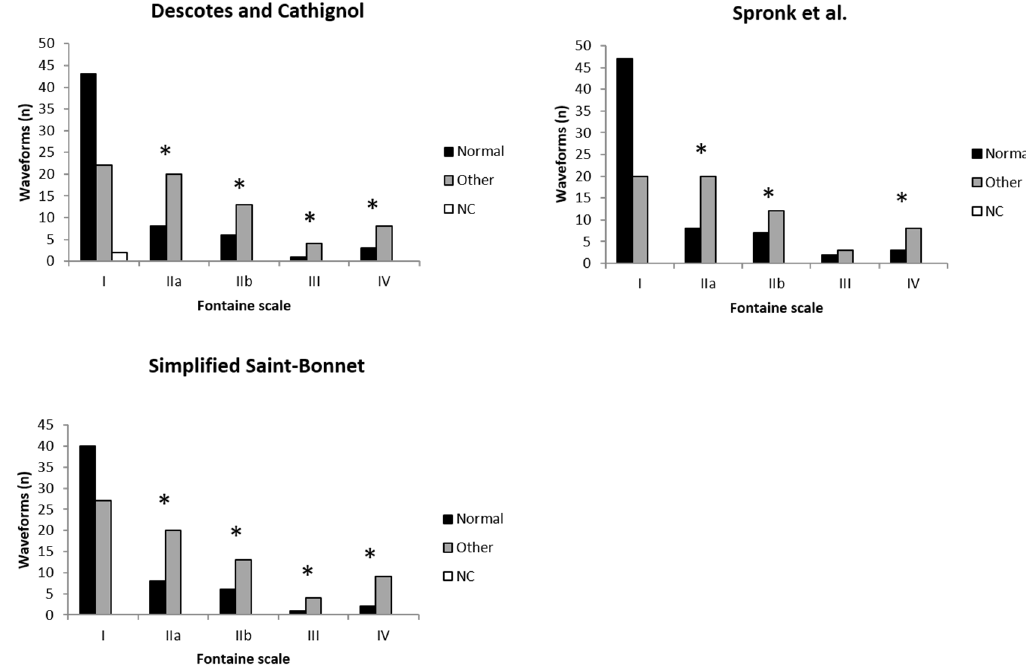
Figure 3. Number of normal and abnormal waveforms according to the Fontaine scale. In this case, waveforms refer to the